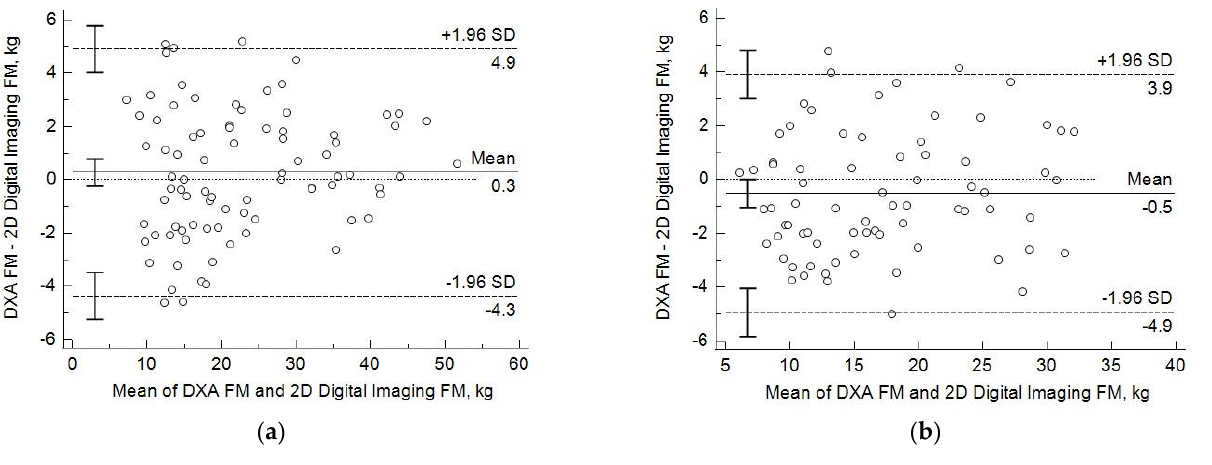
Figure 4. Bland – Altman plots illustrate the differences between individual dual X-ray absorptiometry (DXA)-measured and two dimensional (2D) digital image-predicted fat mass (FM) values as a function of the mean values of females ( a ) and males ( b ). Linear regression line describes the bias and 95% confidence intervals (1.96 SD) indicate the limits of agreement. Bars indicate 95% confidence intervals for mean and LOA values.